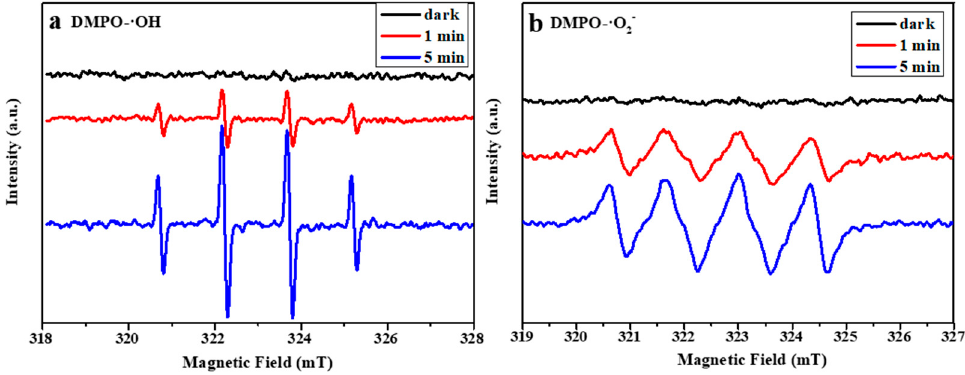
Figure 6. ESR spectra of the DMPO-·OH ( a ) and DMPO-·O 2 − ( b ) for CeVO 4 -V 2 O 3 sample prepared with 10 mL EG. with 10 mL